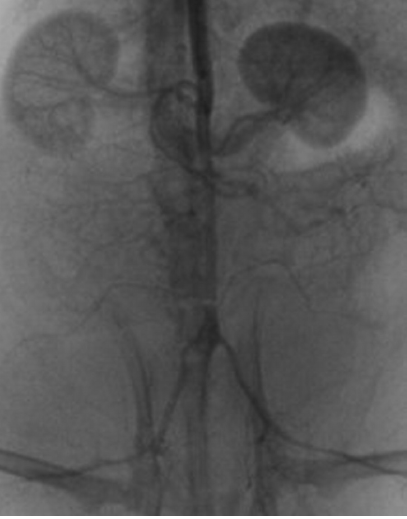
Figure 2 - 2D Angiographic image of aortic bifurcation. Superimposition and overlapping determine loss of three-dimensional information; for example, it is impossible to resolve the angle of bifurcation of the arteries